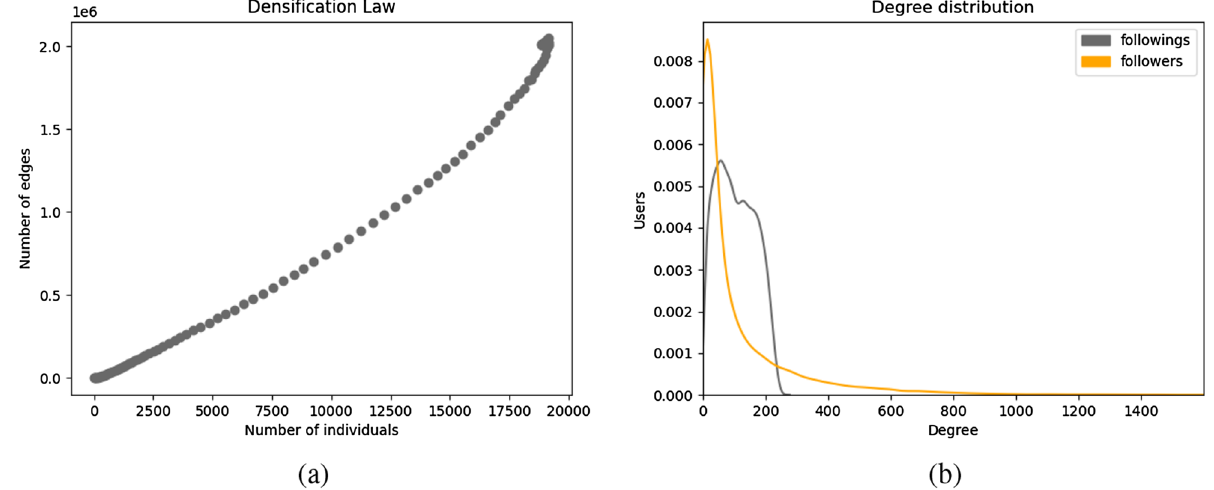
Figure 6. ( a ) Number of edges and ( b ) degree distribution of directed networks generated using the selected model.